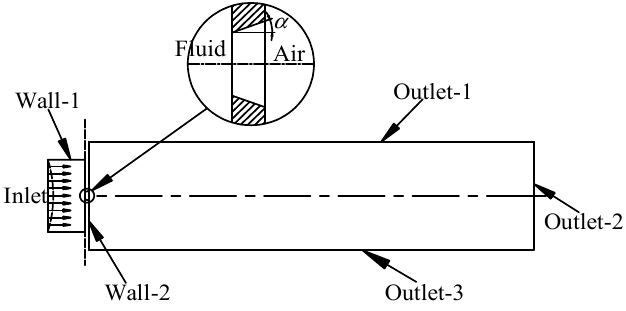
Figure 8. The injection model of the nozzle.